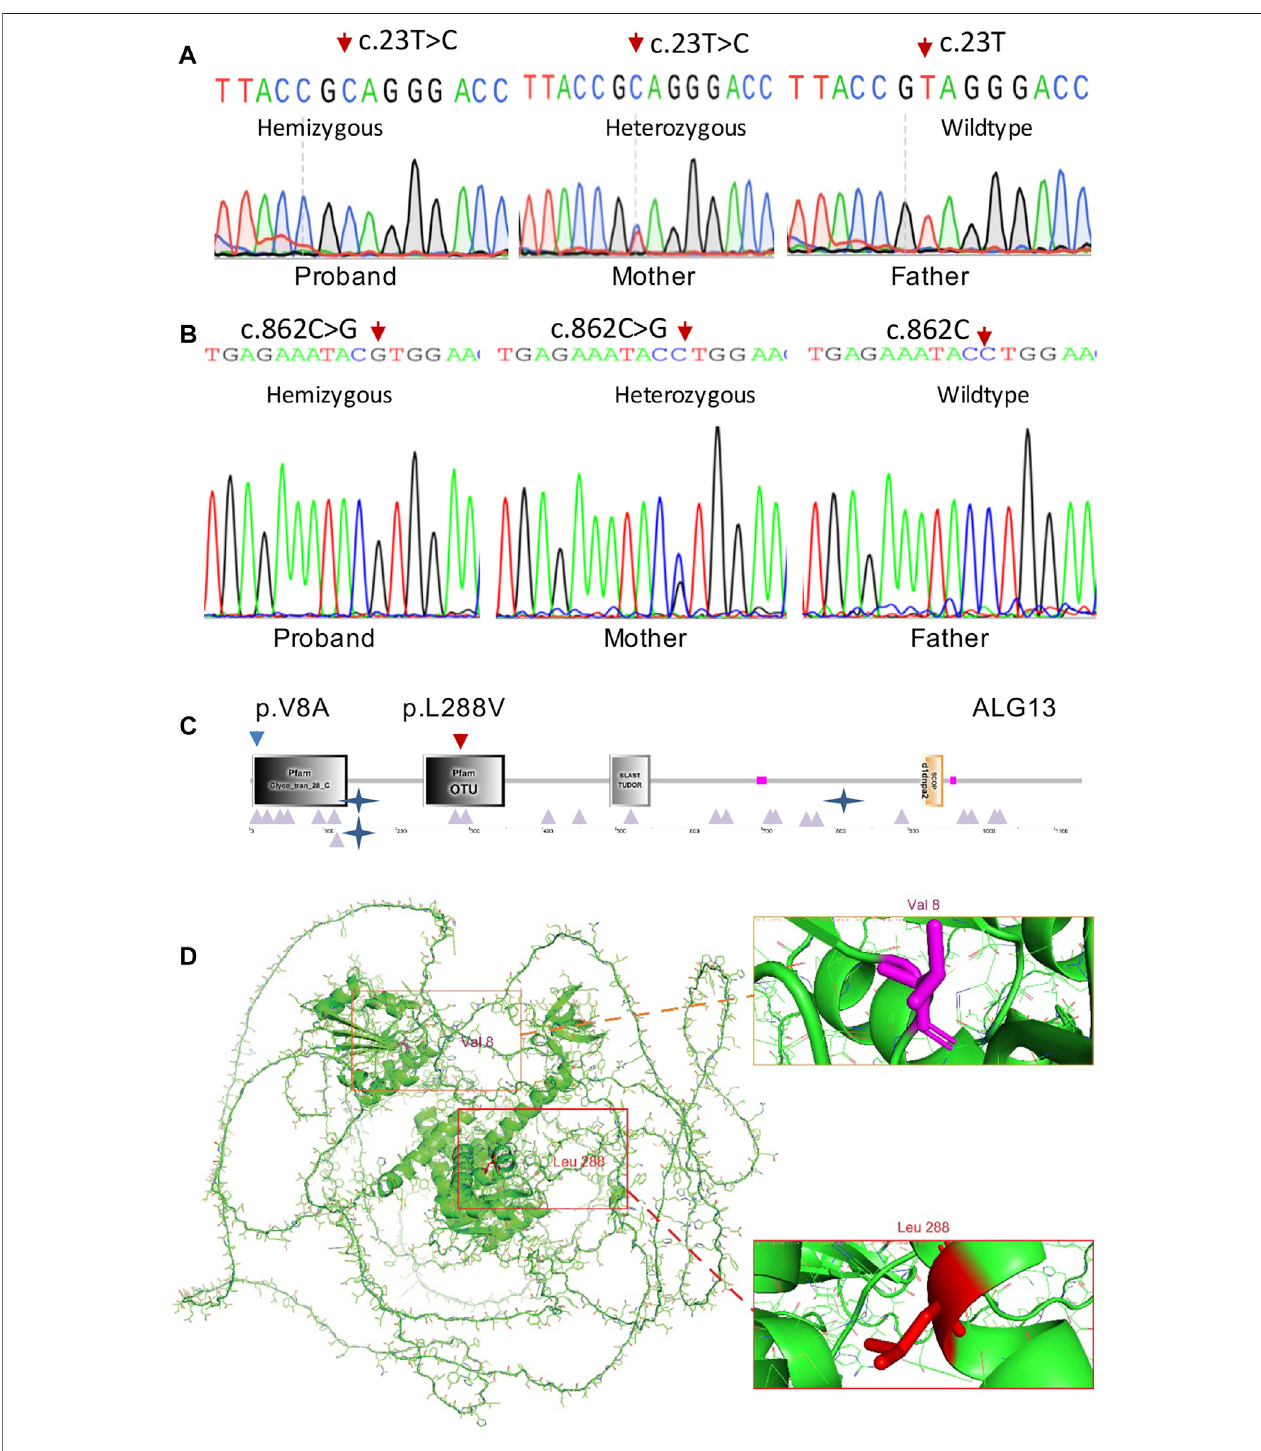
FIGURE 2 | ALG13 mutations and expression. (A) Sanger sequencing con fi rmation of the c.23T > C mutation in case 1 and his mother. (B) Sanger sequencing con fi rmation of the c.862C > G mutation in case 2 and his mother. (C) Schematic representations of functional domains of ALG13. The p.V8A mutation of family 1 is located in the Glyco_tans_28 domain at N-terminus (amino acid 3 – 133). The p.L288V mutation of family 2 is mapped in the OUT domain (amino acid 237 – 348). (D) Residue p.V8 and p.L288 positions are indicated in red in the 3-dimensional structure of the ALG13 protein.